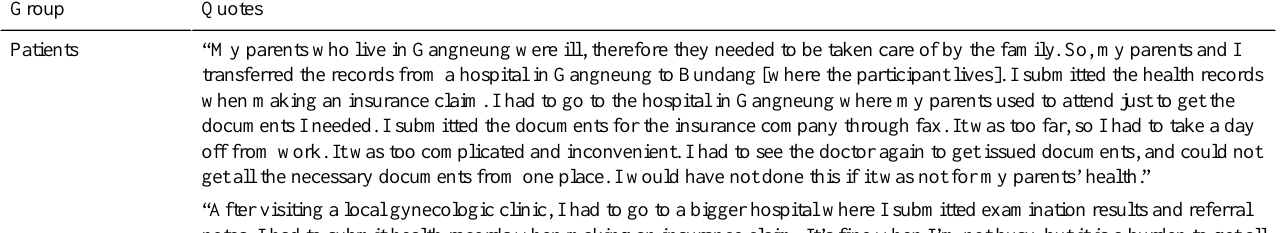
Table 3. Prior experience related to the awareness of blockchain, hospital information exchange (HIE), and personal health record (PHR) systems. QuotesGroup